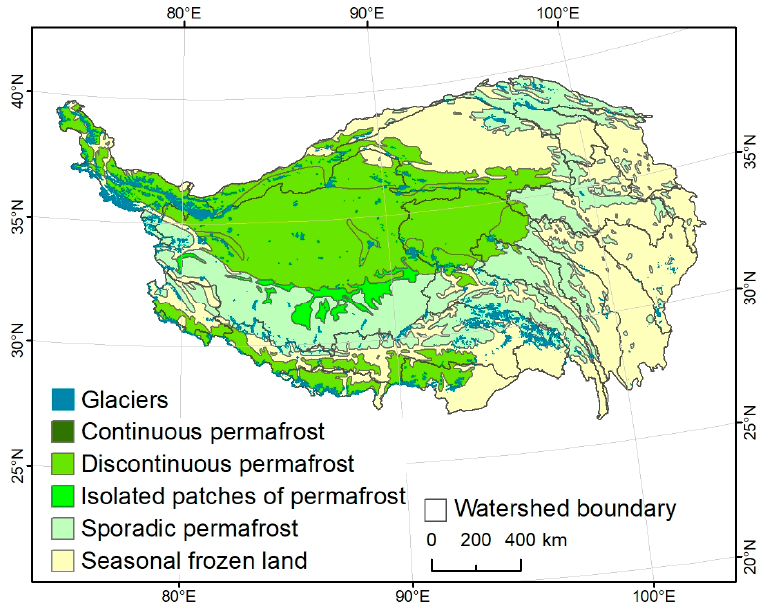
Figure 2. Spatial pattern of glacier cover and different permafrost categorizes on the Tibetan Plateau.